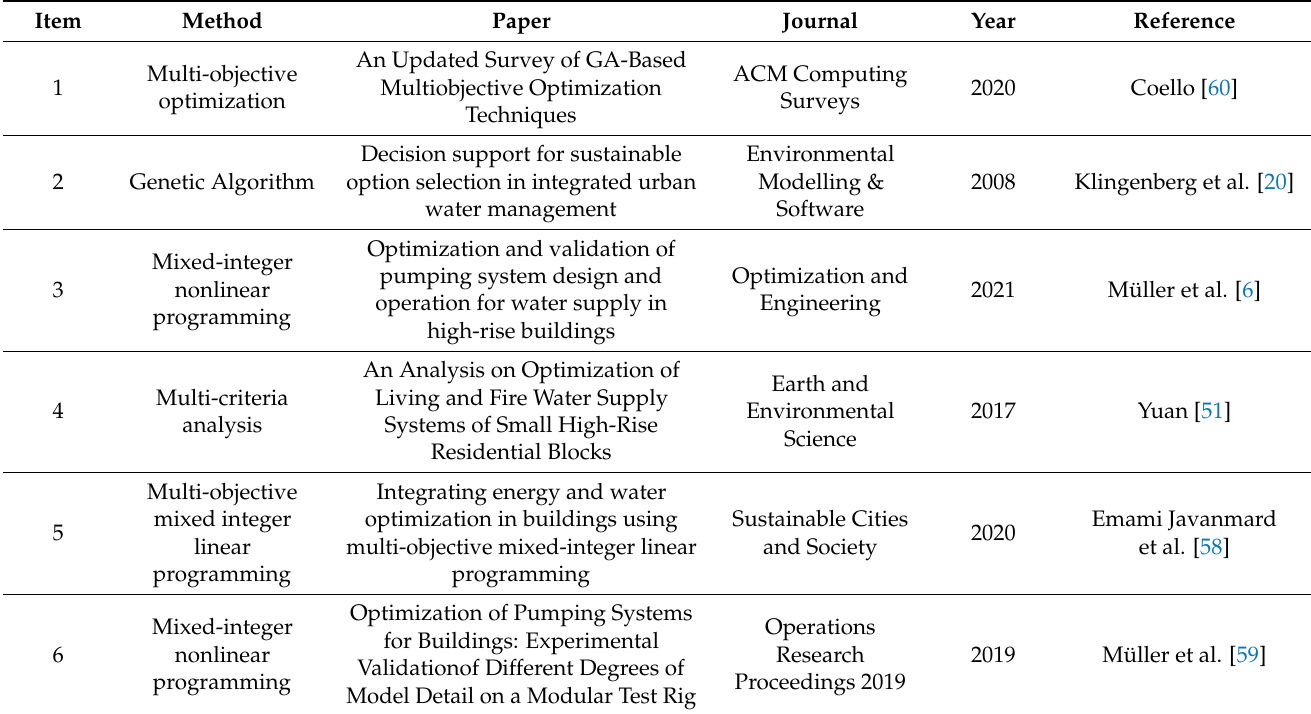
Table 3. Traditional optimization methods that can be applied in the building water pumping